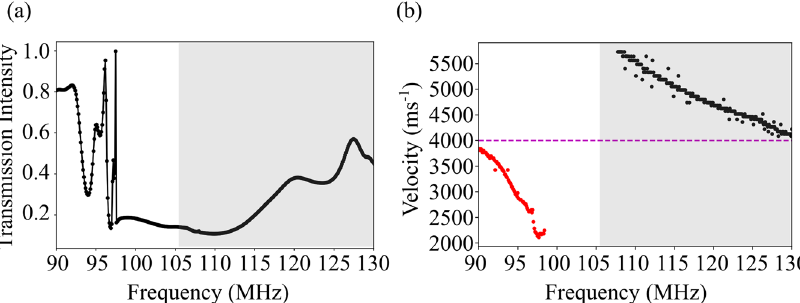
Fig. 2 Transmission intensity and phase velocity data obtained from frequency domain modelling. Transmission intensity a and calculated phase velocity data b obtained from frequency domain models. The patterned model comprises unpatterned areas before and after a patterned array (Array#1) consisting of a 12 × 1 array using periodic boundary conditions for computational ef fi ciency (Supplementary Fig. 2). a The black markers highlight the calculated transmitted SAW intensity. b Red markers highlight the frequencies predicted to exhibit slower velocities than the standard 3998 ms − 1 and black markers highlight the frequencies predicted to exhibit faster velocities. Grey shaded regions represent the main bandgap region. The magenta dashed line represents the SAW velocity in unpatterned 128° Y-X lithium niobate (3998 ms − 1 ). Data obtained at 0.1 MHz intervals using COMSOL Multiphysics ® 38